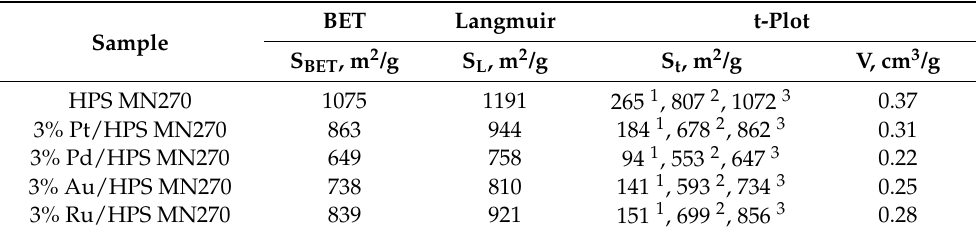
Table 2. Results of the studies of the initial sample of HPS and the catalysts with the method of low-temperature nitrogen adsorption. BET Langmuir t-Plot Sample S BET , m 2 /g